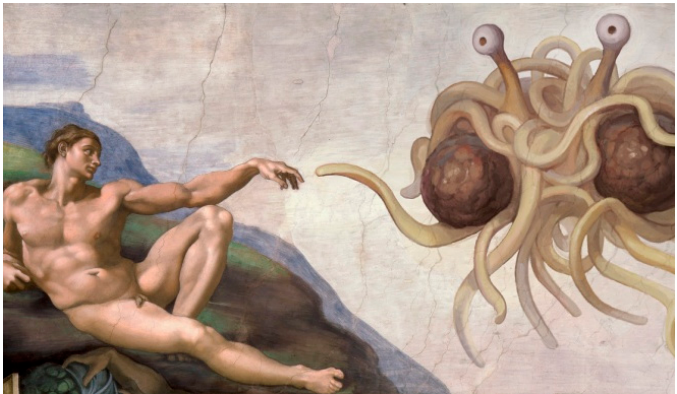
Figure 6. The Flying Spaghetti Monster by Niklas Jansson. Public Domain by the